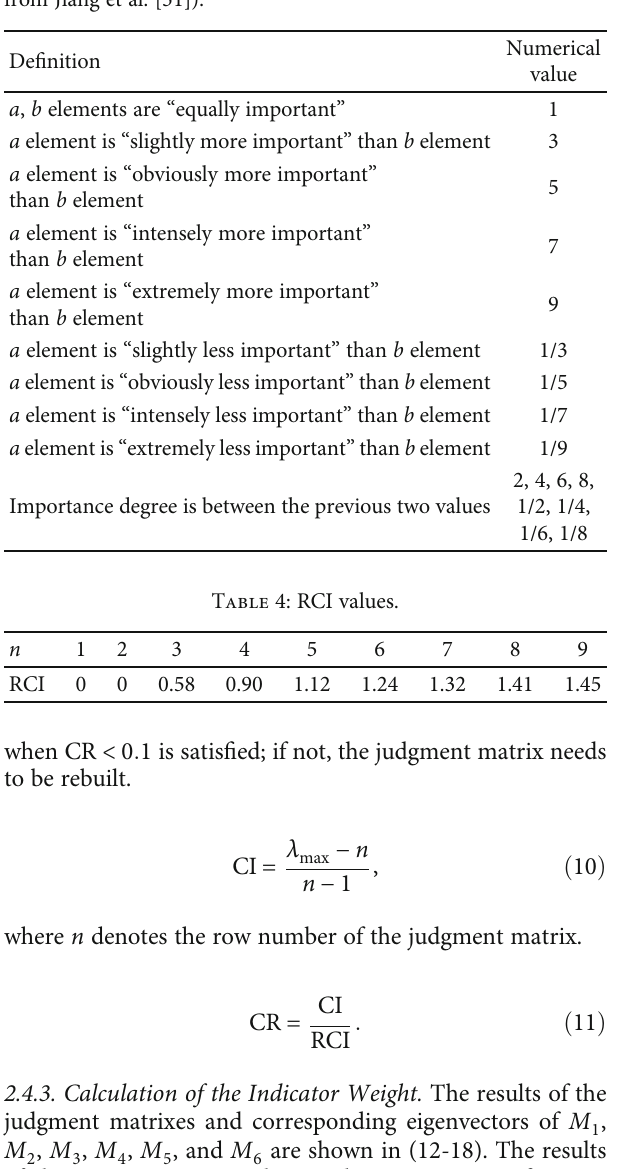
Table 5: λ max and CR of judgment matrixes.